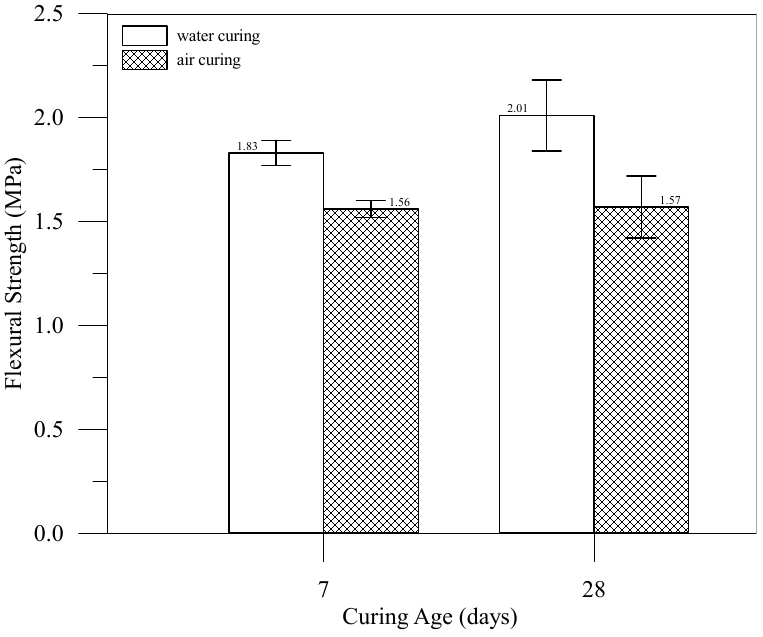
Figure 5. Histograms of flexural strength.